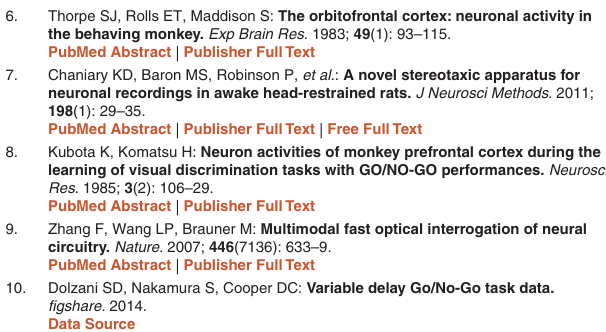
figshare. 2014. Data